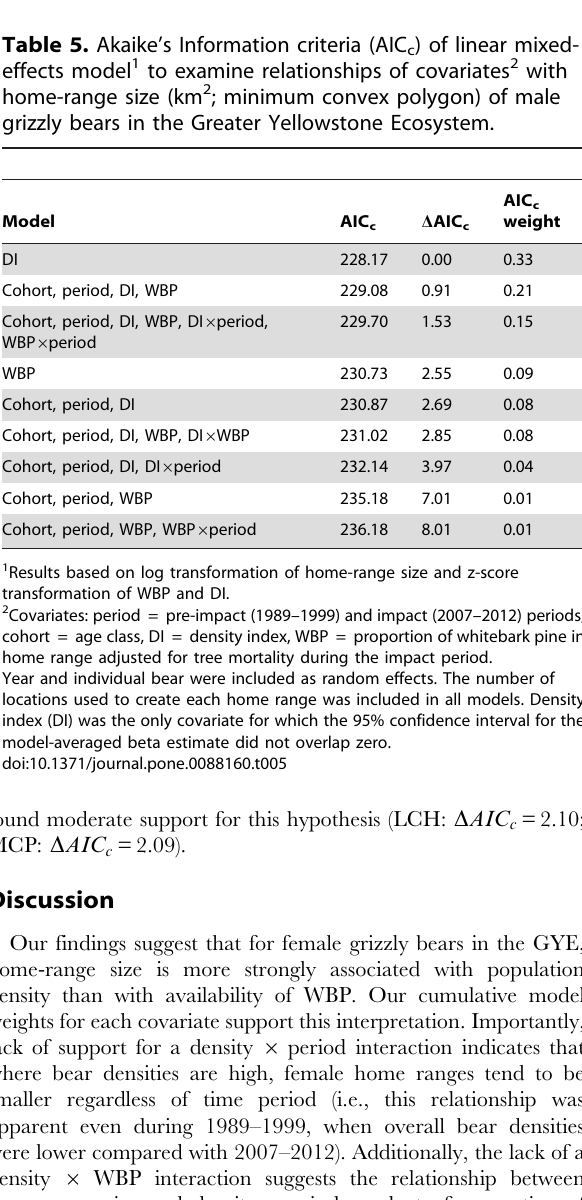
Table 5. Akaike’s Information criteria (AIC c ) of linear mixed- effects model 1 to examine relationships of covariates 2 with home-range size (km 2 ; minimum convex polygon) of male grizzly bears in the Greater Yellowstone